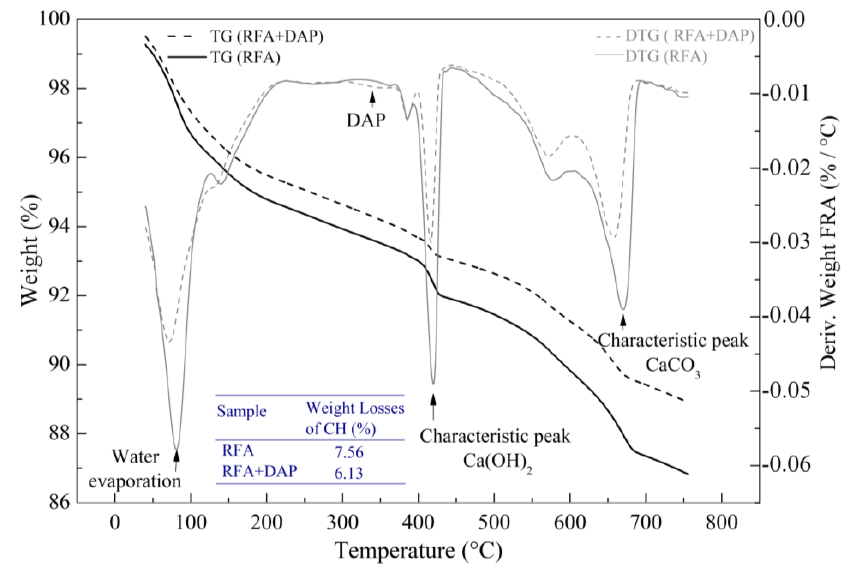
Figure 9. TGA results of RFA and RFA+DAP samples at 0.5 mol/L – 7d – 20ºC.